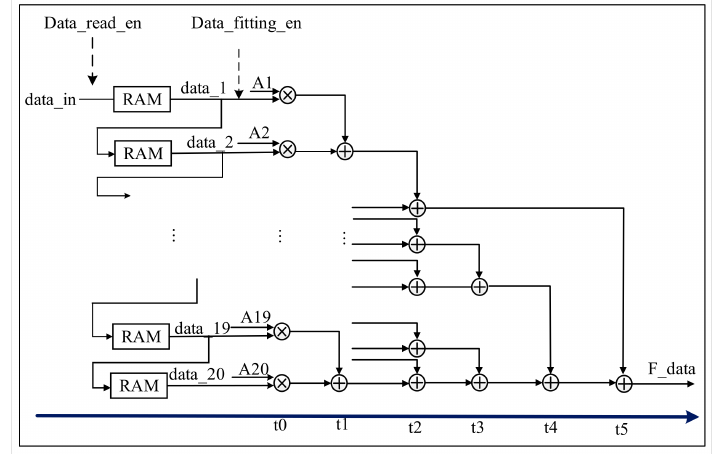
Figure 7. Filter